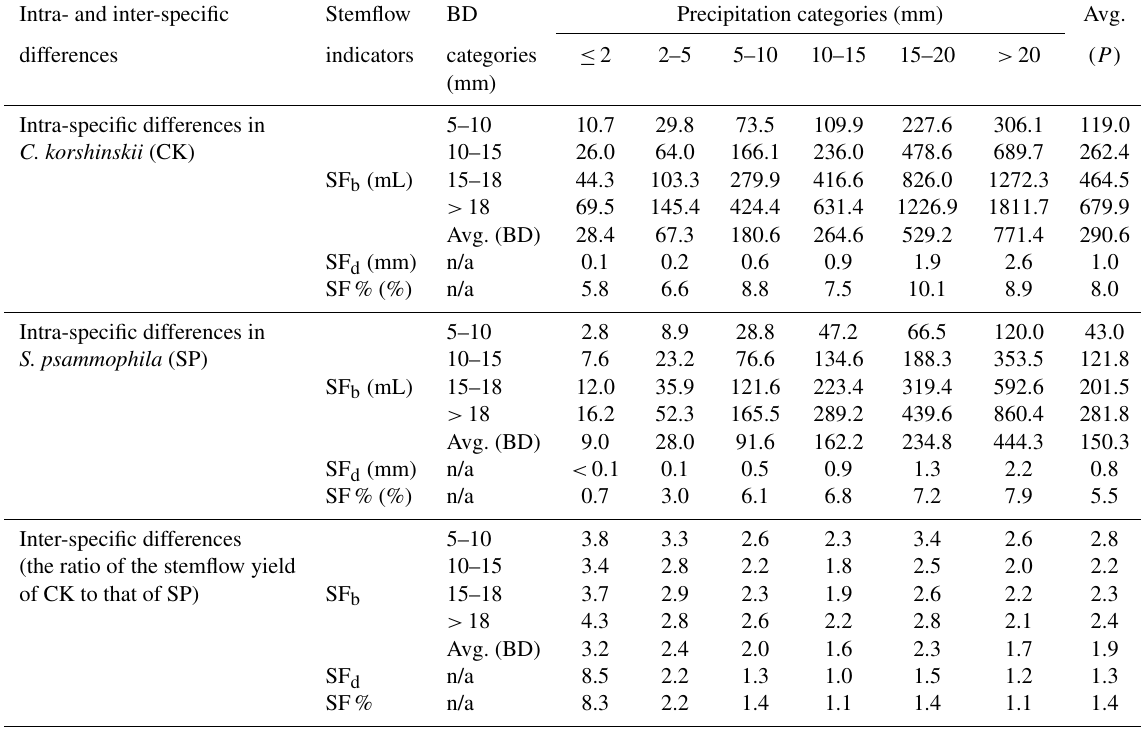
Table 2. Comparison of stemflow yield (SF b , SF d and SF%) between the foliated C. korshinskii and S. psammophila . Intra- and